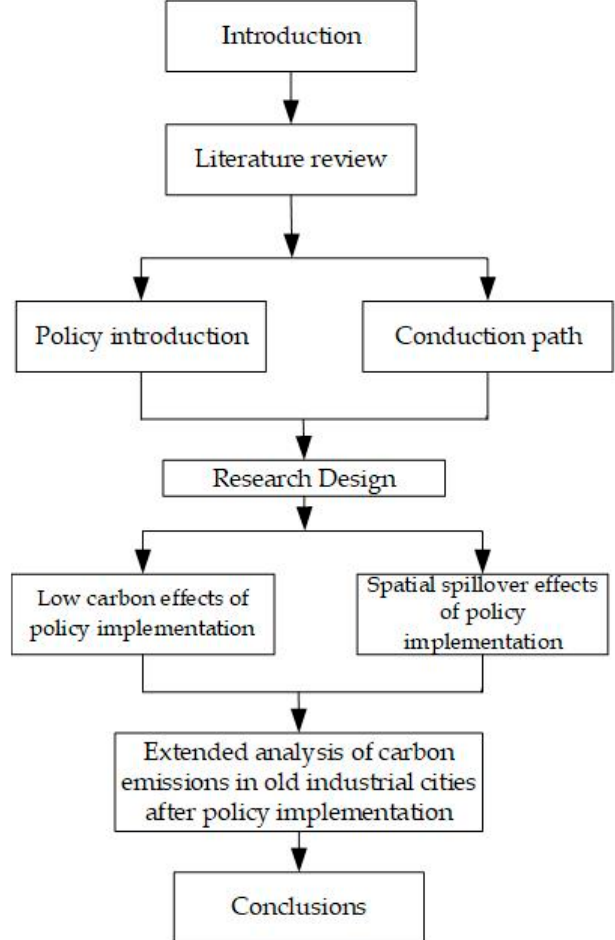
Figure 1. Flow chart of research framework.